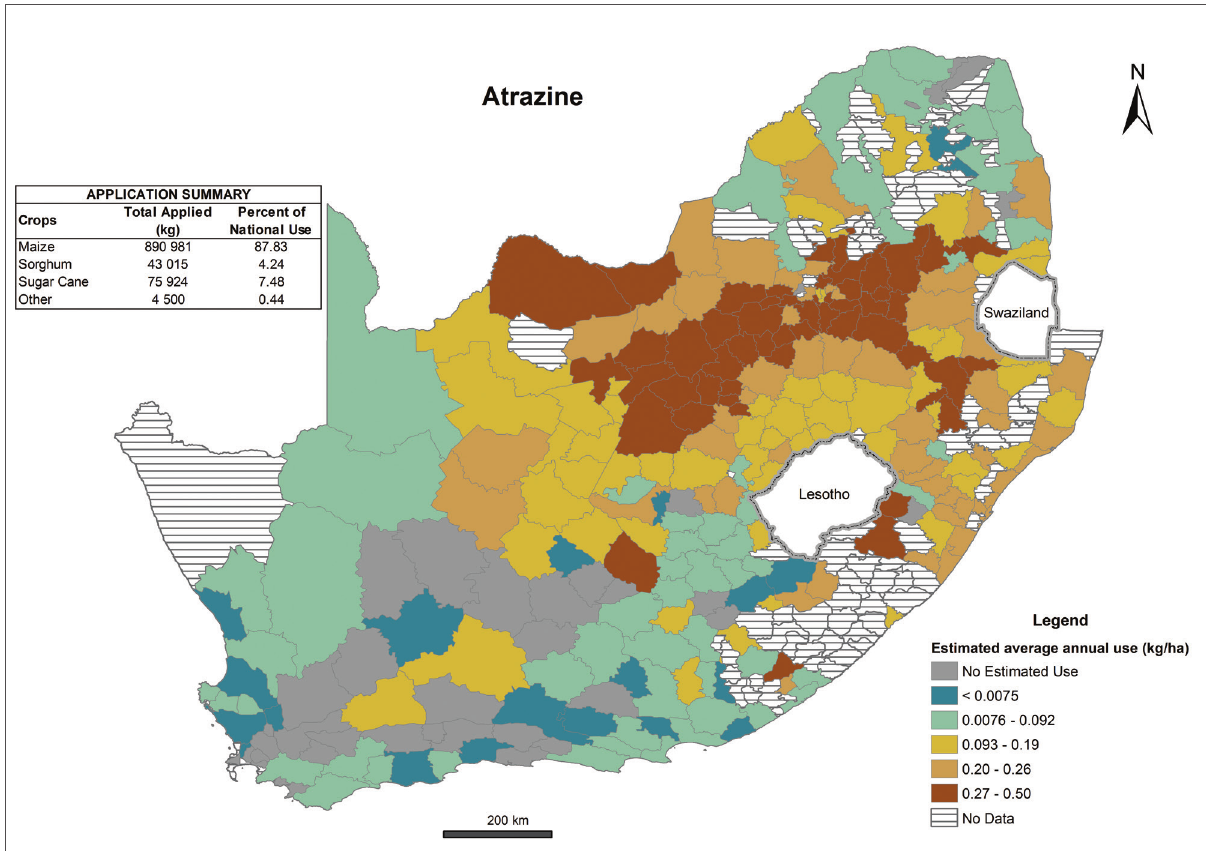
Figure 2: An example of a map showing the average annual use of atrazine per hectare of agricultural land in magisterial districts of South Africa for the year 2009, estimated from pesticide sales and agricultural crop census